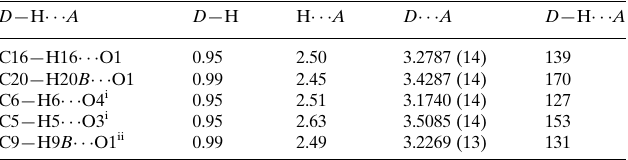
Hydrogen-bond geometry (A˚ , (cid:2)